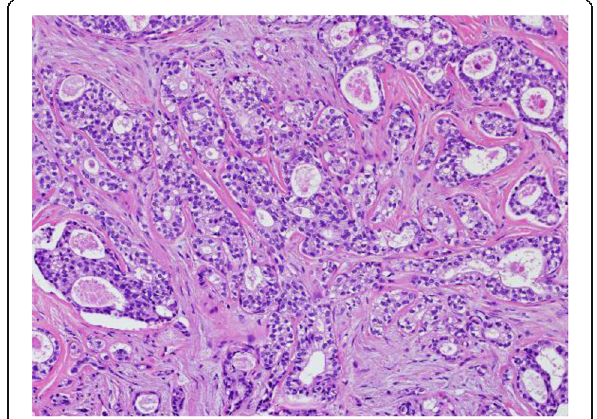
Fig. 1 Histopathological findings of the resected specimen (hematoxylin-eosin stain, ×200). Invasion of the stroma by ductal adenocarcinoma